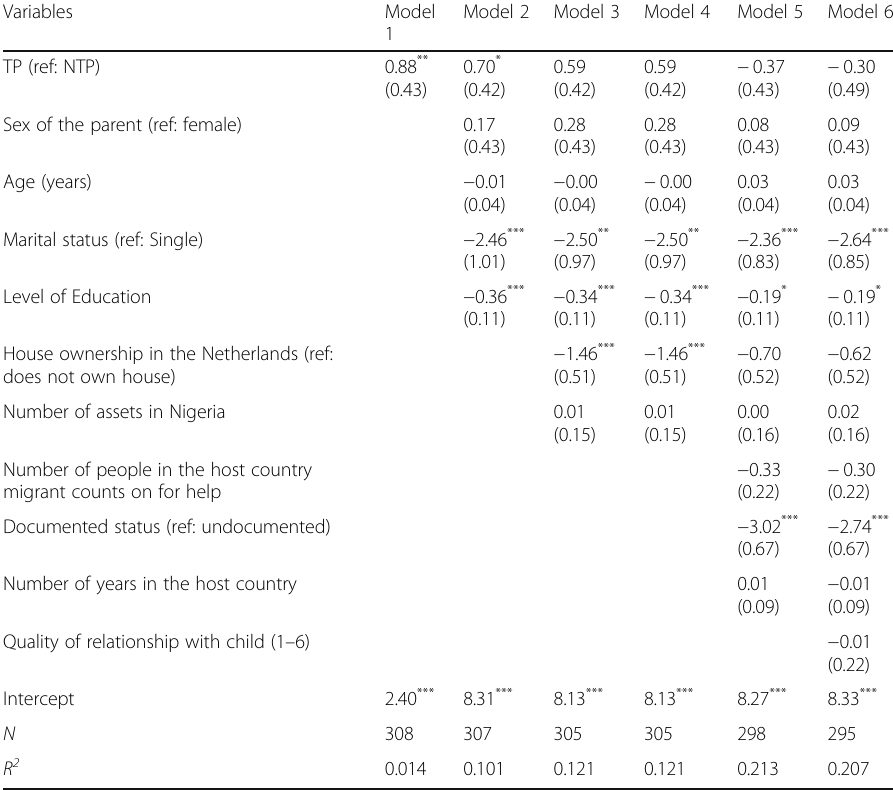
Table 7 Ordinary Least Squares regressions predicting emotional well-being, Ireland